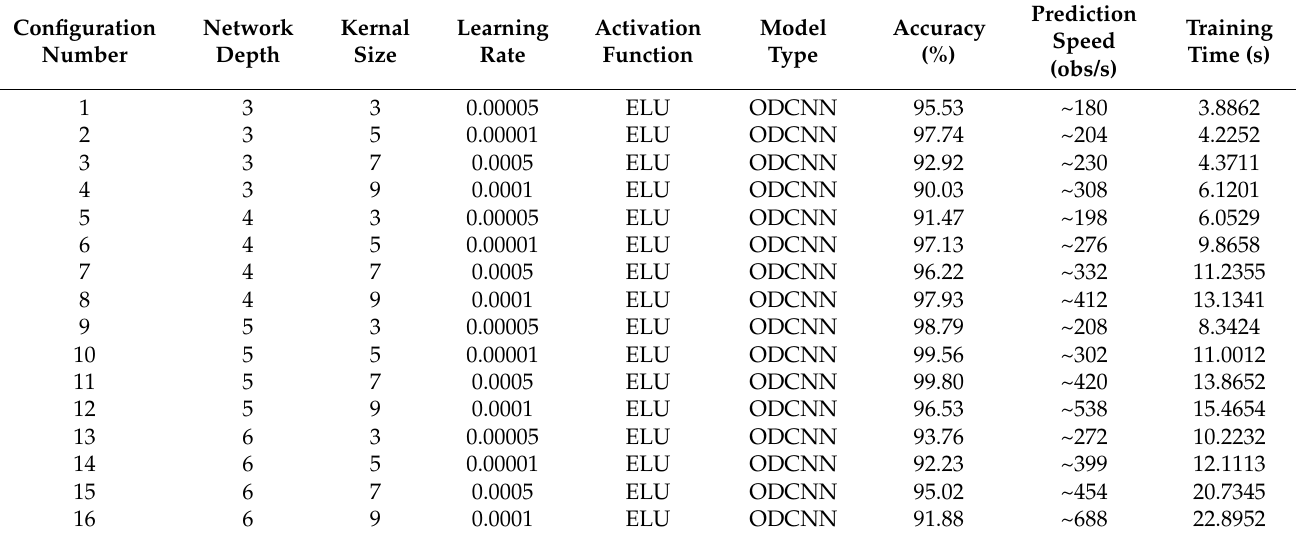
Figure 18. Parallel coordinate plot for the ensemble RUSBoosted tree. Three elements were considered when examining the effect of the ODCNN model on the classification performance: network depth, convolutional kernel size, and learning rate. As listed in Table 7, the numbers from 1 to 16 in the first column represent 16 configurations. The second to the fourth columns denote the three mentioned factors. The row in the table corresponds to an instance. For instance, the fifth configuration indicates that the network depth is four, the convolutional kernel size is three, and the learning rate is 0.00005. The seventh column is the accuracy measure, which indicates the classification performance of the model using the given hyperparameters. The eighth and ninth columns represent the prediction speed and training time, respectively. Table 7. Comparison of the configuration